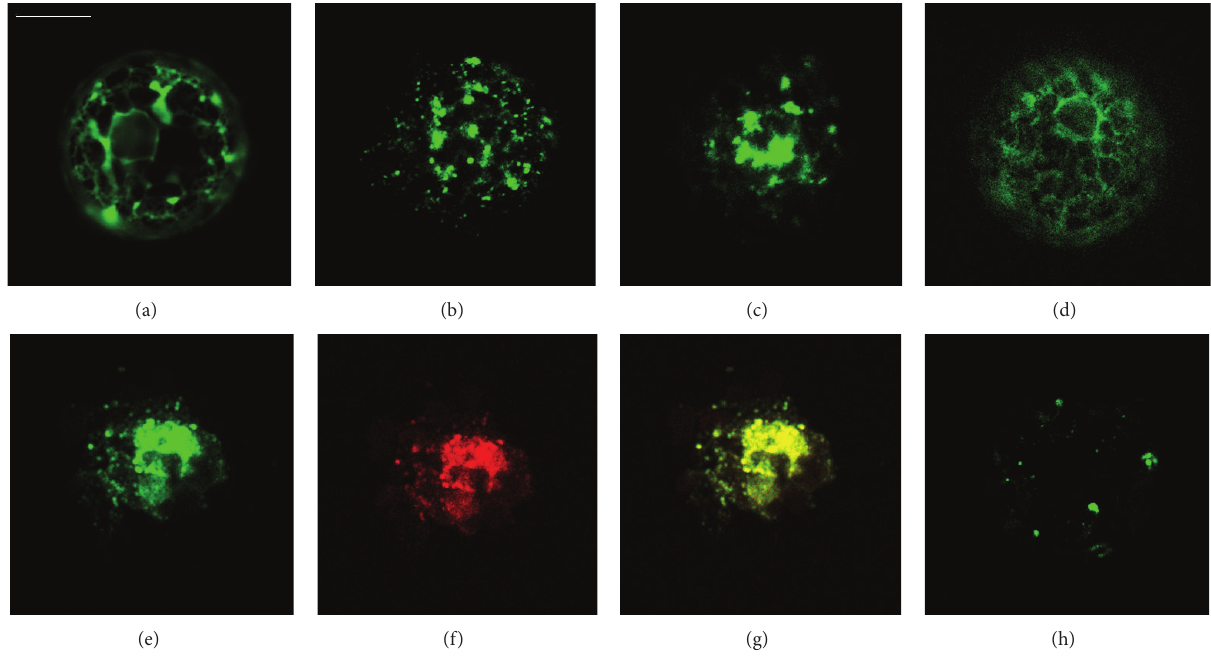
Figure 1: Subcellular localization of AtCslA2-GFP. AtCslA2-GFP transiently expressed in tobacco leaf protoplasts labels ER and Golgi stacks (a). Brefeldin A determines the aggregation of the Golgi and the redistribution of the fluorescence in the ER (b–d). AtCslA2-GFP colocalises with the Golgi marker ST52-mRFP (e–g). Golgi stacks are the only fluorescent compartment labelled after 2 h of cycloheximide treatment (h). Scale bar: 20 𝜇 m.